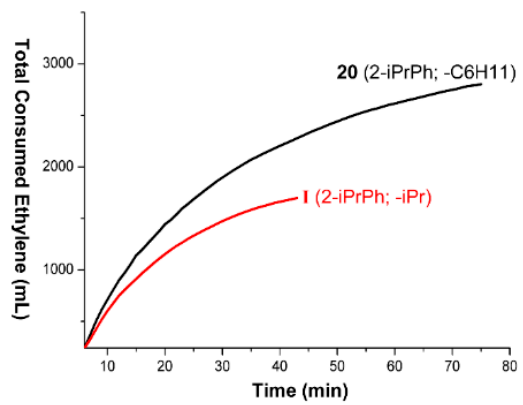
Figure 3. Ethylene consumption monitored with a mass flow controller.